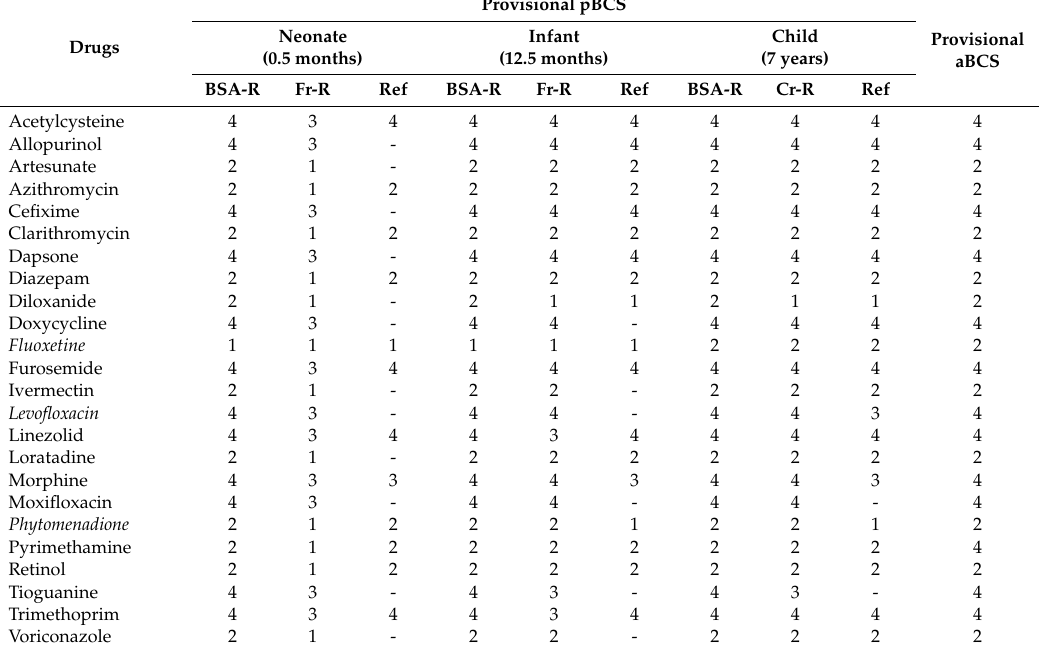
Table 4. Provisional pBCS classification of drugs with favorable changes with respect to aBCS. Drugs with favorable changes with the referenced dose dosage in all age stages are given in bold. Drugs in italics indicate changes in pBCS classification with the referenced dosage not in all of the age